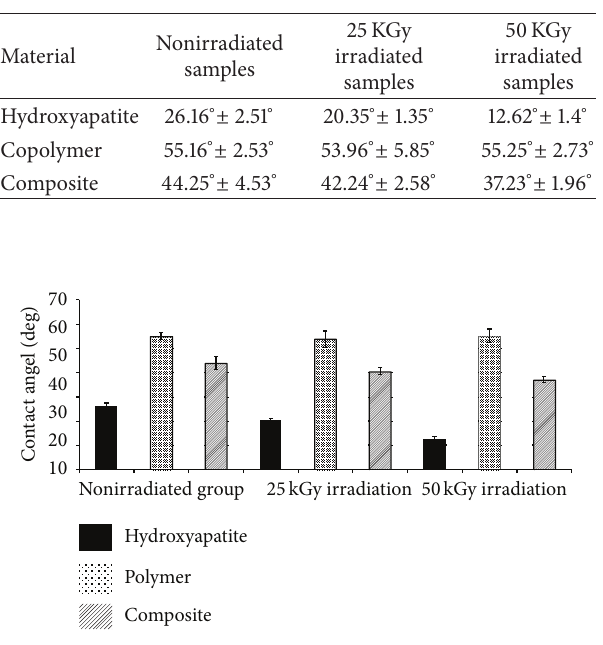
Figure 10: Contact angle of hydroxyapatite, copolymers, and composites irradiated with 0, 25, and 50KGy doses of gamma